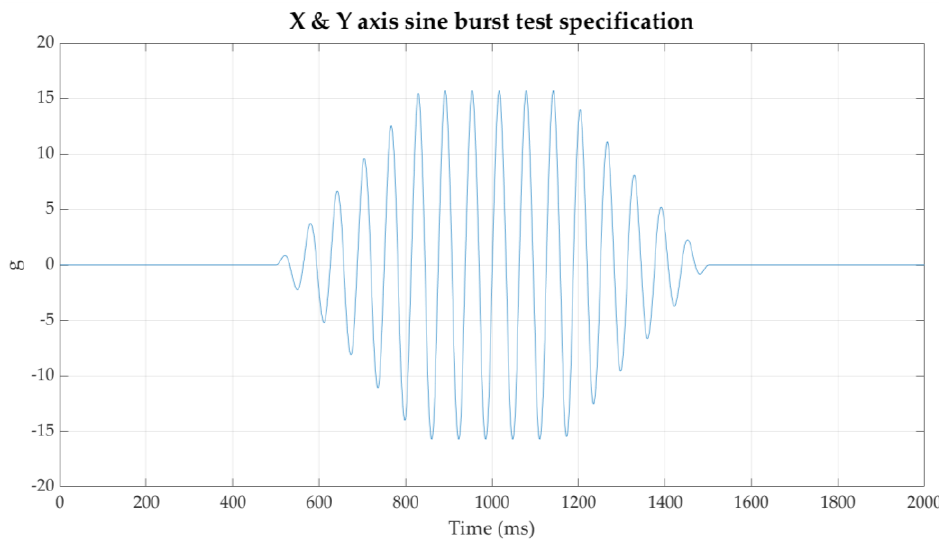
Figure 10. Z-axis sine burst test specification of g-force acceleration (in units of g = 9.8 m s −2 ) with respect to time.